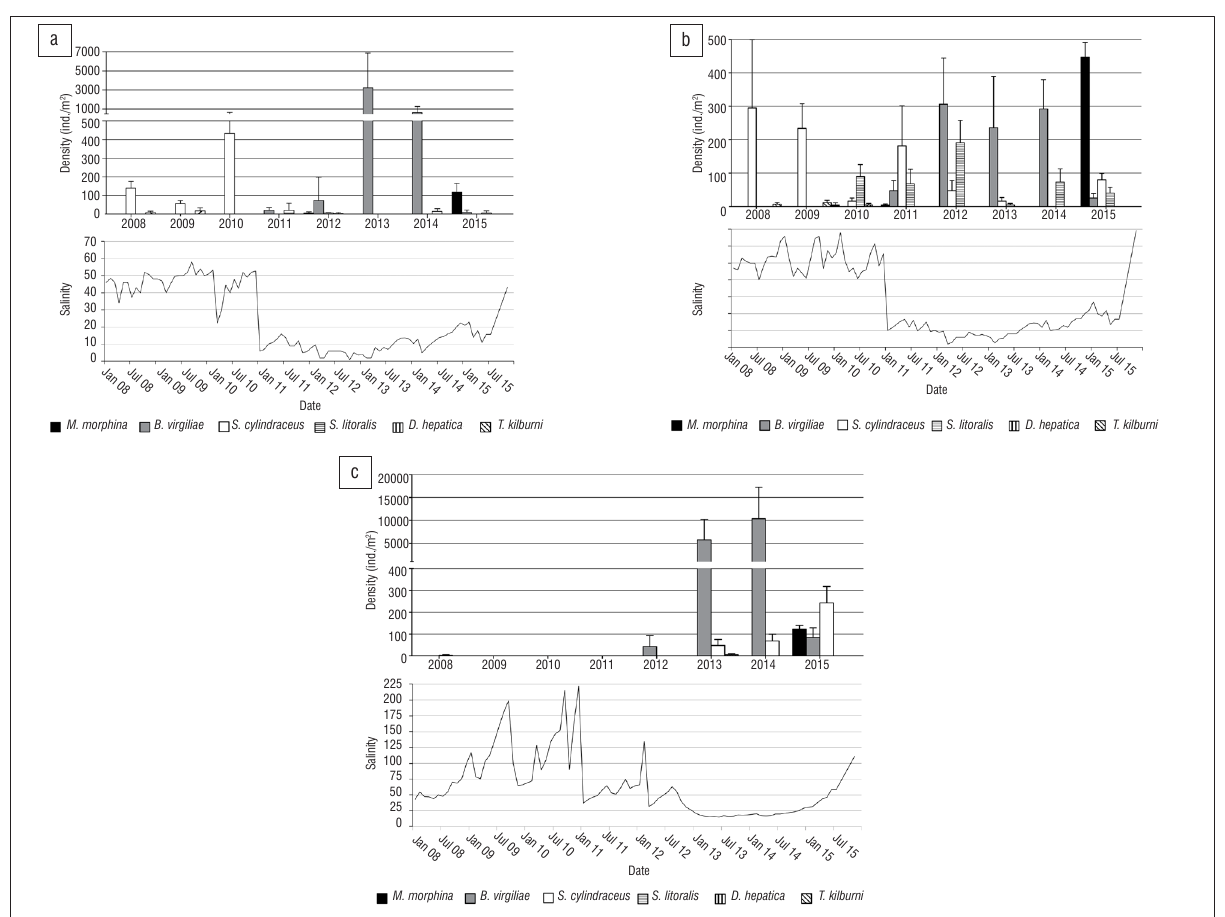
Figure 2: Population density (ind./m 2 ) of bivalves ( Meretrix morphina, Brachidontes virgiliae, Dosinia hepatica, Salmacoma litoralis, Solen cylindraceus and Tellinides kilburni ) and average salinity at (a) Catalina Bay, (b) Charter’s Creek and (c) Lister’s Point from 2008 to 2015. Error bars show s.e. Samples were collected by Ekman grab. Table 1: The estimated density, shell length and fresh weight biomass (mean±s.d.) of Meretrix morphina at three sites within Lake St Lucia in 2015 Temperature (°C) Salinity Turbidity (NTU)